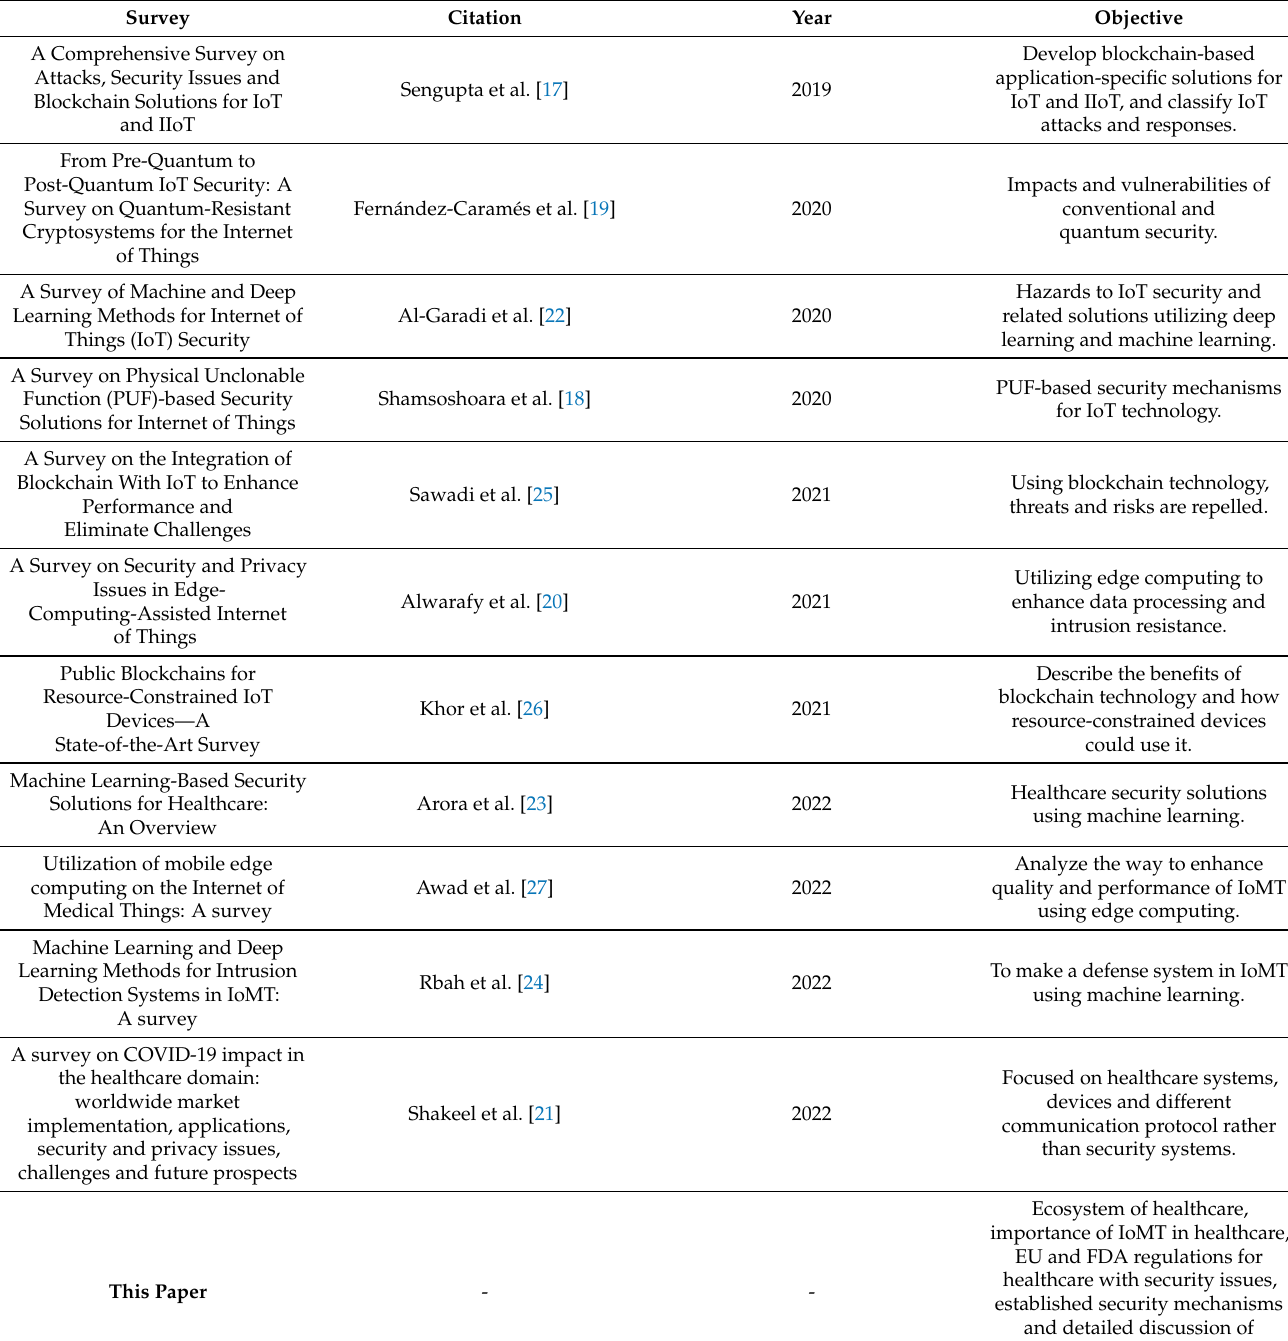
Table 1. Comparative analysis of related